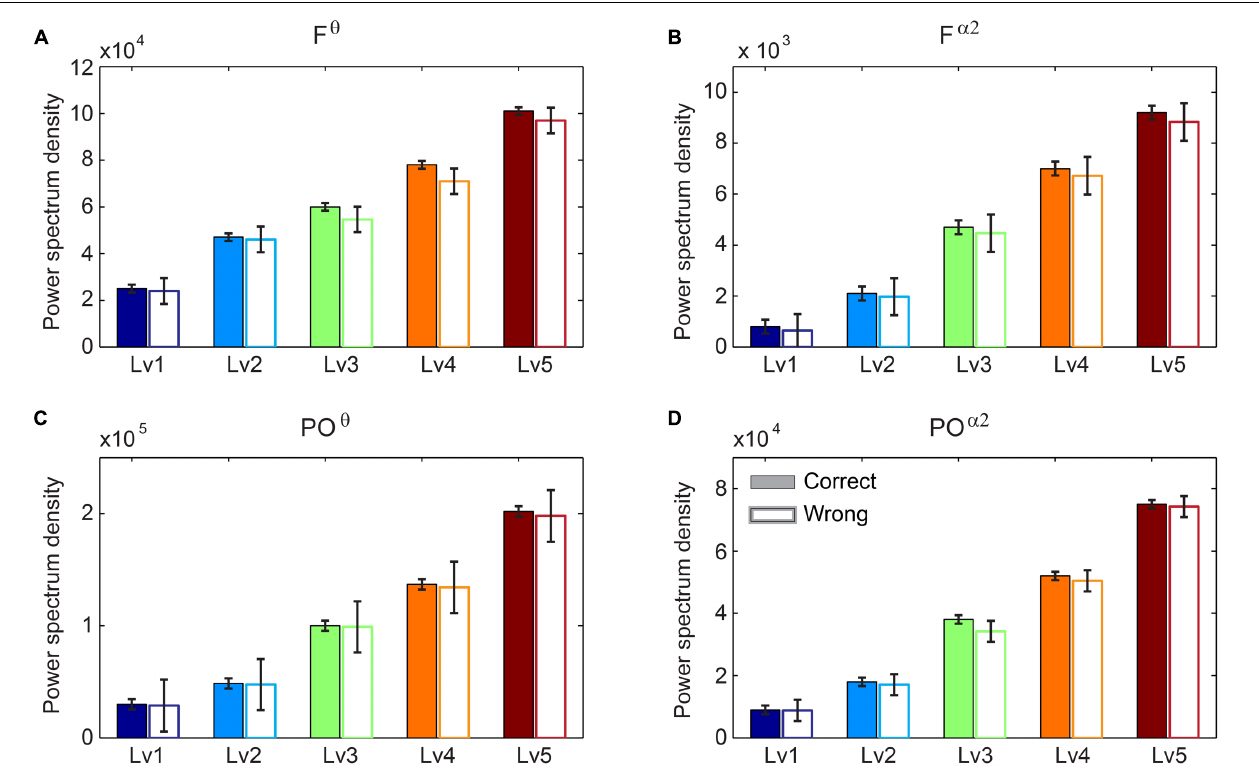
FIGURE 3 | Group-averaged power spectrum in θ band (5–6 Hz) (A) over frontal (F) bilaterally areas and (C) over parieto-occipital (PO) sites and in α 2 band (10–13 Hz) (B) over F bilaterally areas and (D) over PO sites for the five CWLs in both correct and wrong trials. Bars represent mean ± standard error of mean (SEM). No statistical significant differences were detected based on Wilcoxon rank sum test ( p < 0.001; Bonferroni corrected across